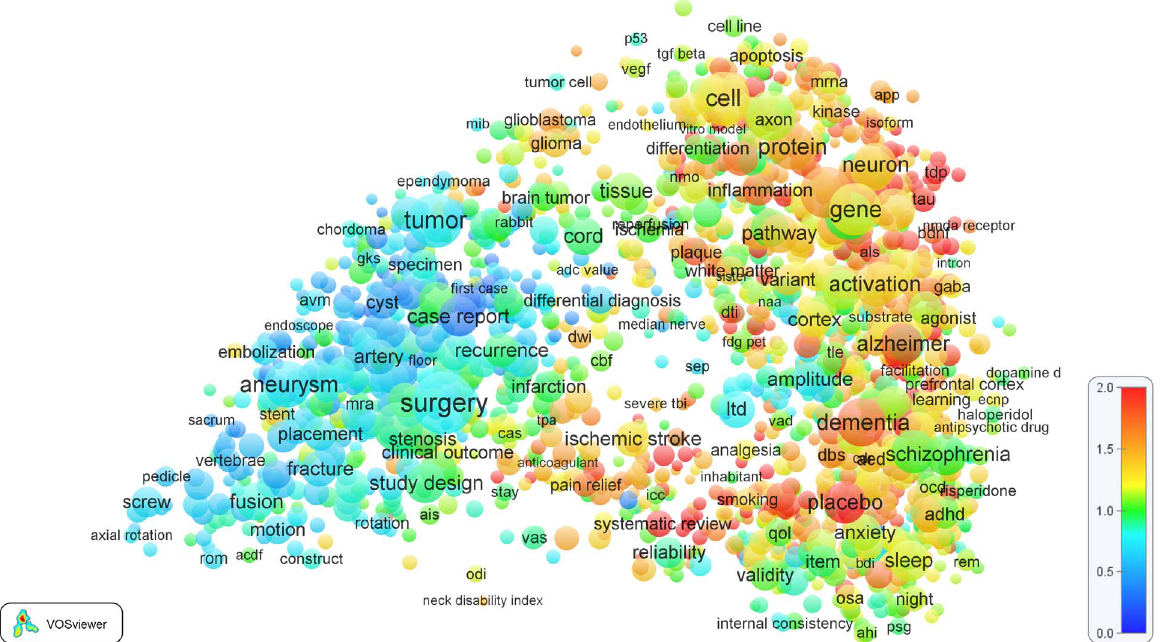
Figure 1. Term map of the Clinicalneurology field. Colors indicate the average citation impact of the publications in which a term occurs. doi:10.1371/journal.pone.0111530.g001 PLOS ONE |